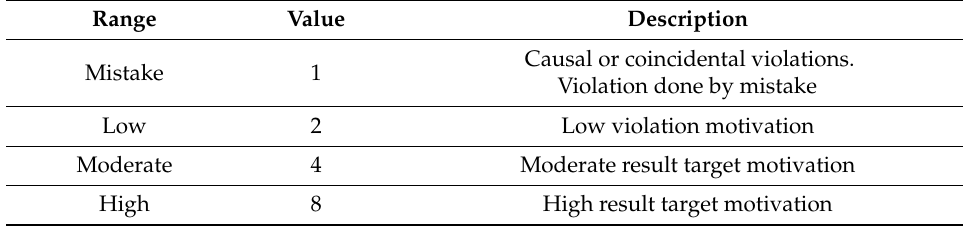
Table 6. Attack potential factor: motivation.